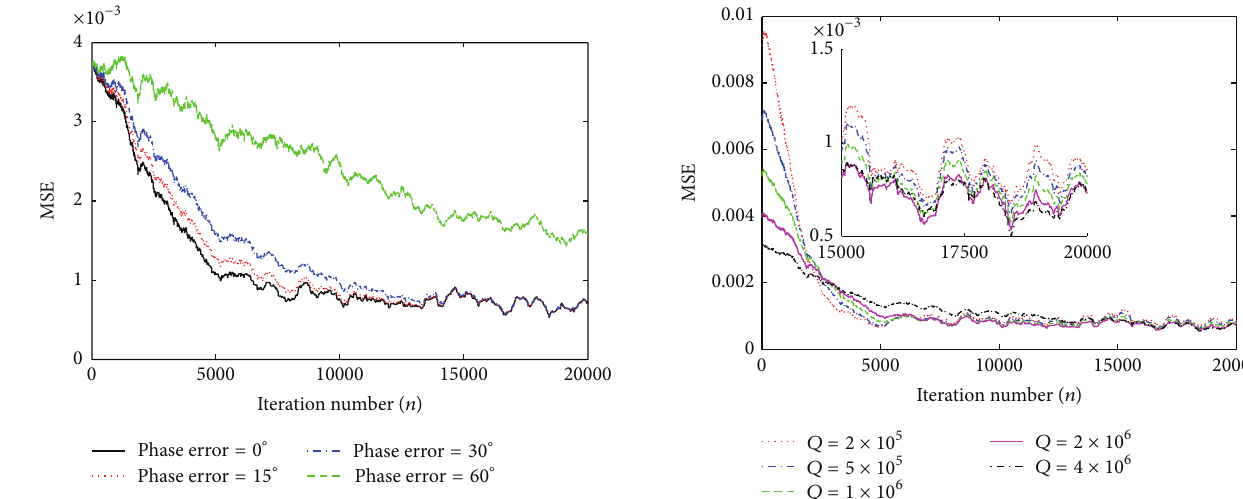
the adaptive FxLMS feedforward controller are combined as the hybrid controller, which can reduce substantially the displacement amplitude of plate/ACLD system subjected to a complicated disturbance without requiring more control effort and is more stable and smooth. On the other hand, the hybrid controller demonstrates a rapider and more stable convergence rate than the adaptive feedforward controller. Meanwhile, the hybrid controller demonstrates much better robustness than individual LQG feedback control or adaptive feedforward control.